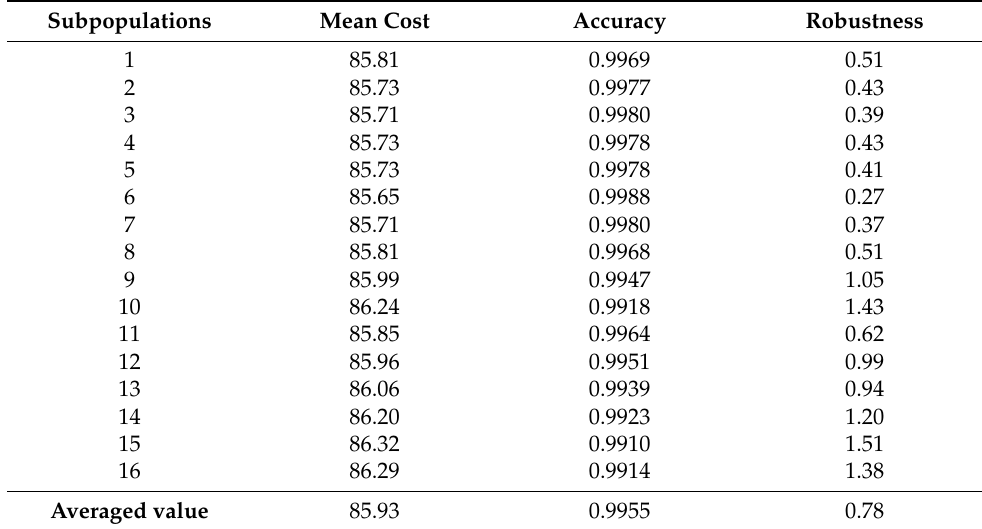
Table 4. Cross-section under flexure. LSRD and GSRD. Performance